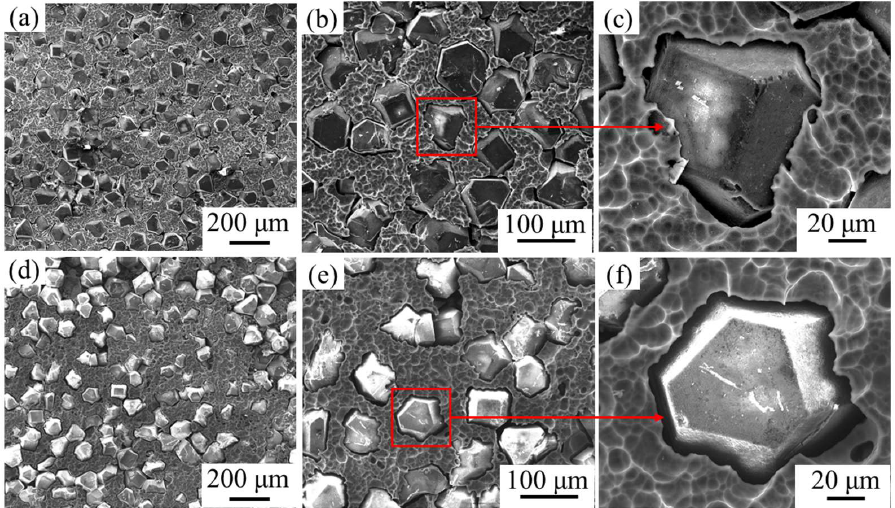
Figure 7. Surface morphology of diamond/aluminum composite after electrified accelerated corro- sion: ( a – c ) uncoated diamond/aluminum composite; ( d – f ) W-coated diamond/aluminum compo- site.